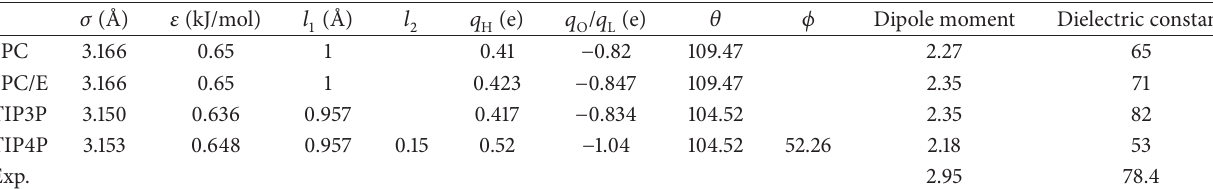
Table 1: Physical properties of water models [22]. All data is recorded at 25 ∘ and 1atm. 𝑞 oxygen, and lone pair, respectively. 𝜃 and 𝜙 are the H–O–H and lone pair-O–H angles, respectively. 𝜀 and 𝜎 are the well depth and vdW radius,